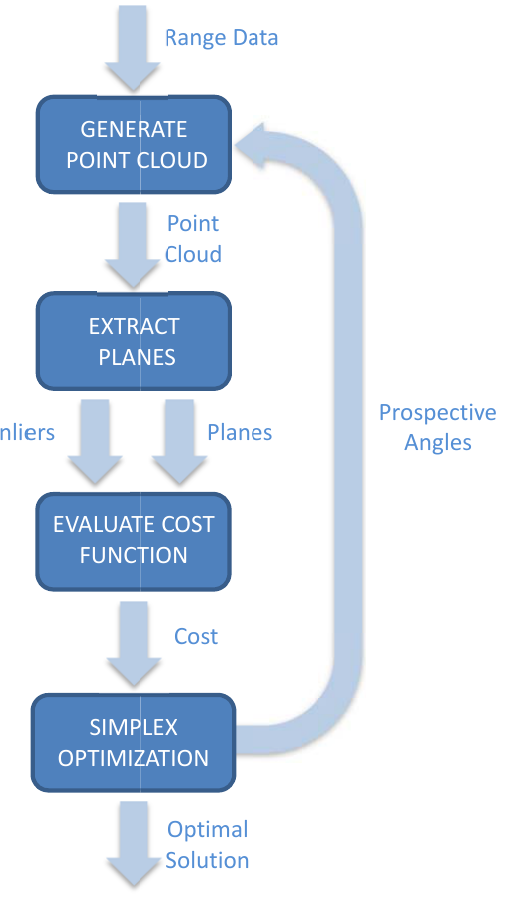
Figure 3. Outline of the calibration